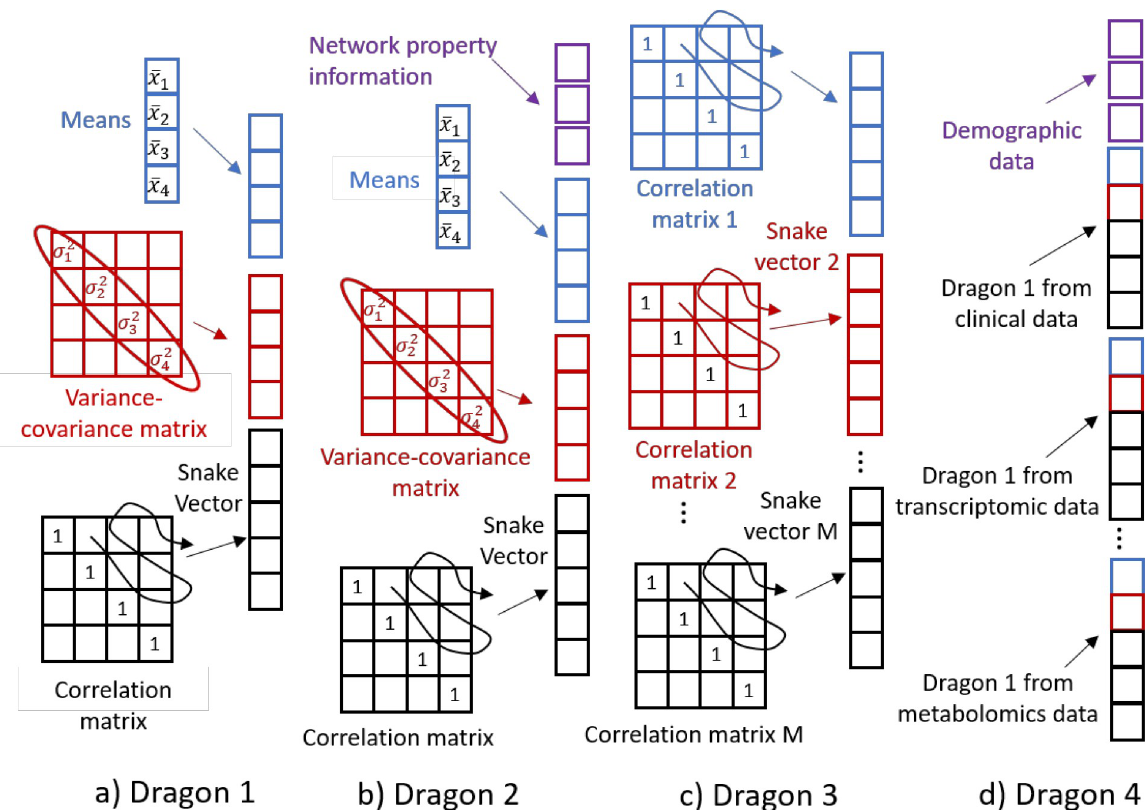
Fig 2. Four types of dragon vectors. A-Dragon 1, includes means and variances of the variables. B- Dragon 2, includes also overall network property information. C- Dragon 3, combines correlations along multiple dimensions of the data matrix or multiple locations. D-Dragon 4 is composed of several dragons presenting different types of clinical and omics